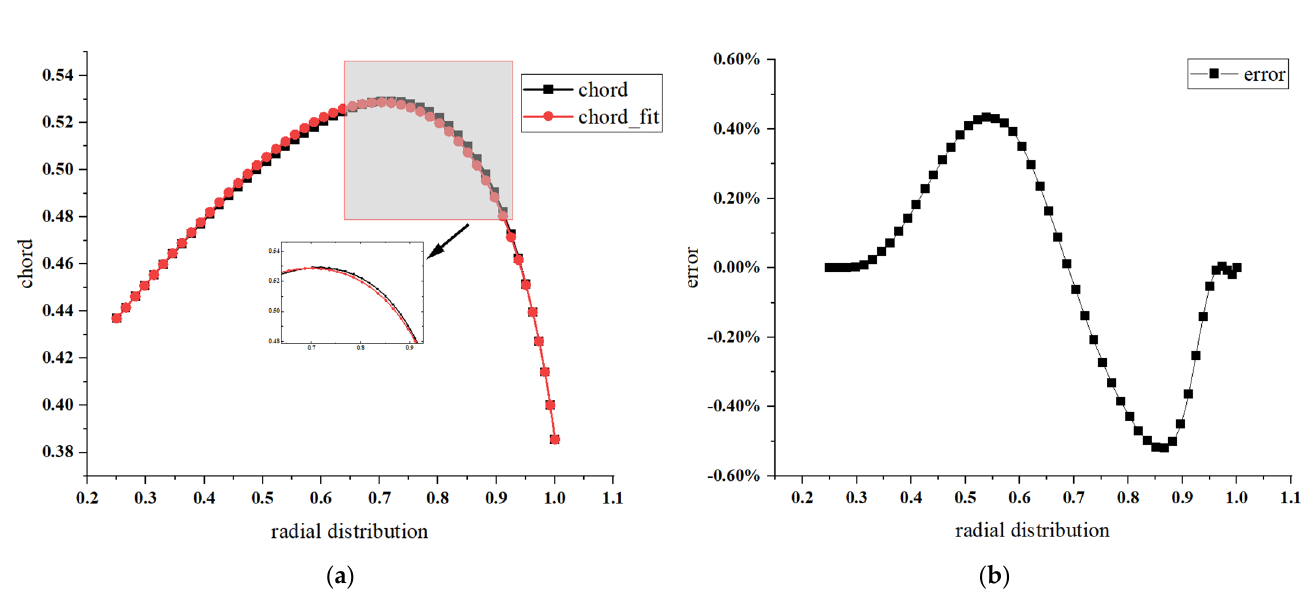
Figure 5. Comparison of chord length curve and chord length fitting curve: ( a ) curve comparison; ( b ) relative error.